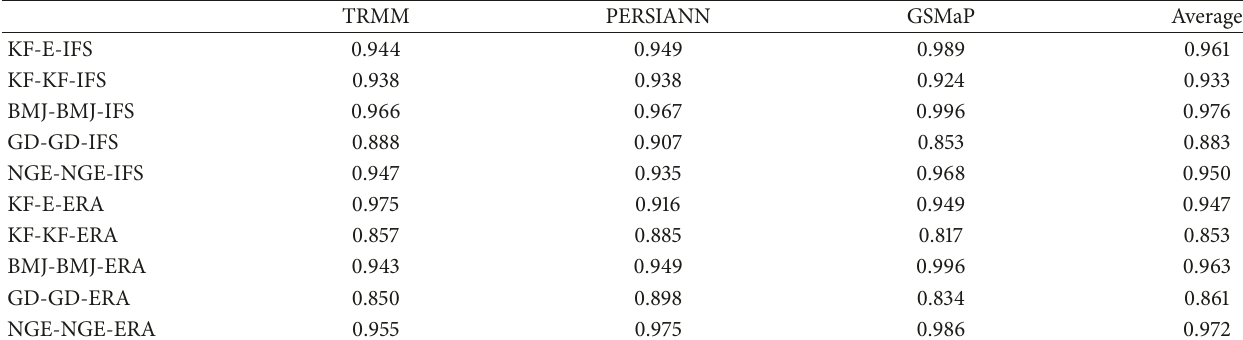
Table 4: Total interest results with respect to each of the three different precipitation observational datasets.